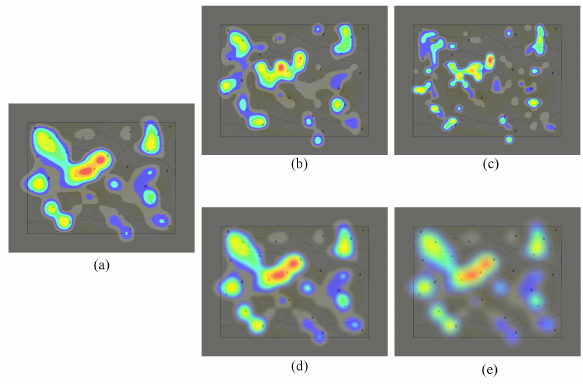
Generation of heatmap visualizations using different values of grid size (gs) & kernel size (ks) and standard deviation (sigma) parameters(s) of the performed Gaussian filter: (a) gs=0.25/3 ≈ 0.083, ks=5, s=3 (b) gs=0.25/4 ≈ 0.063, ks=5, s=3 (c) gs=0.25/6 ≈ 0.042, ks=5, s=3 (d) gs=0.25/3 ≈ 0.083, ks=30, s=20 (e) gs=0.25/3 ≈ 0.083, ks=70, s=50. As the value of grid size is decreased, bigger number of discriminant regions are generated (b, c). As the values of kernel size and sigma are increased, the total image becomes smoother (d, e).